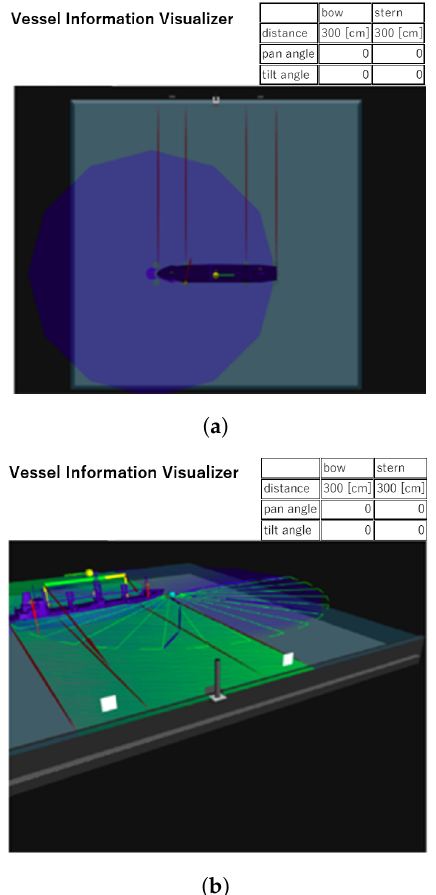
Figure 15. One scene of the user terminal screen: ( a ) one screen drawn from the aerial view; ( b ) one screen zoomed in from the quay of